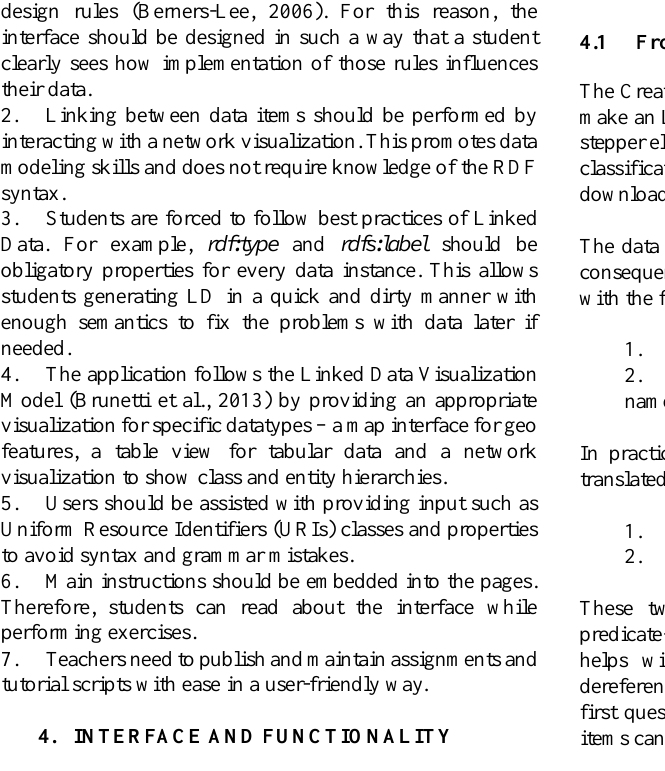
Figure 1. Landing page of LinkDaLe.